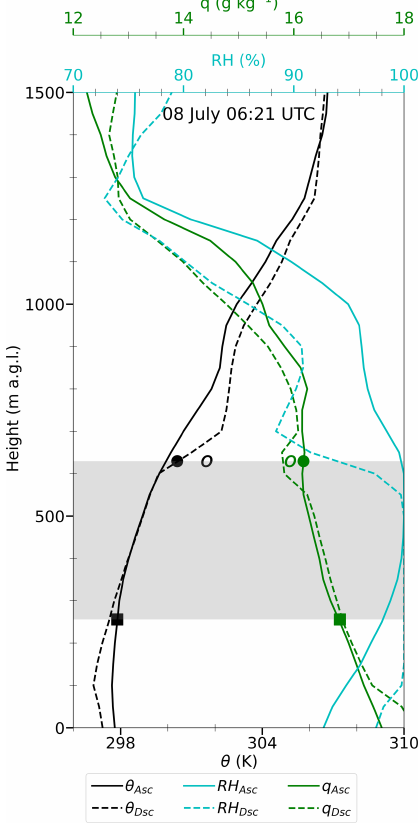
Figure 7. Vertical profiles of the low troposphere acquired by the reusable radiosonde of 8 July 2016 at 06:21UTC when the probe ascends (“Asc”; filled line) and descends (“Dsc”; dashed line). The variables shown are relative humidity (RH), potential temperature ( θ ) and water vapor specific humidity ( q ). The shaded gray delimits the LLSC layer based on ceilometer and cloud-radar measurements. The values of ϕ + ( ϕ − ) (Eq. 4) for θ and q are marked with a dot (square). The filled symbols correspond to the ascent, whereas the unfilled symbols correspond to the descent.